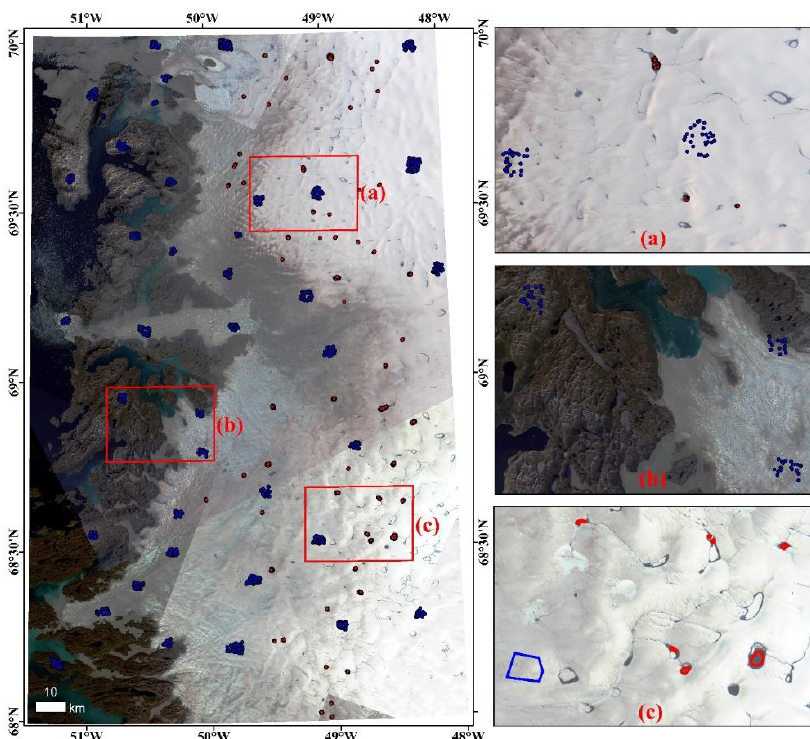
Figure 3. Sample points created from the polygons shown in Figure 2. Red points stand for water samples, and blue points stand for background samples. ( a ‒ c ) correspond to three detailed images. The background image is the same as Figure